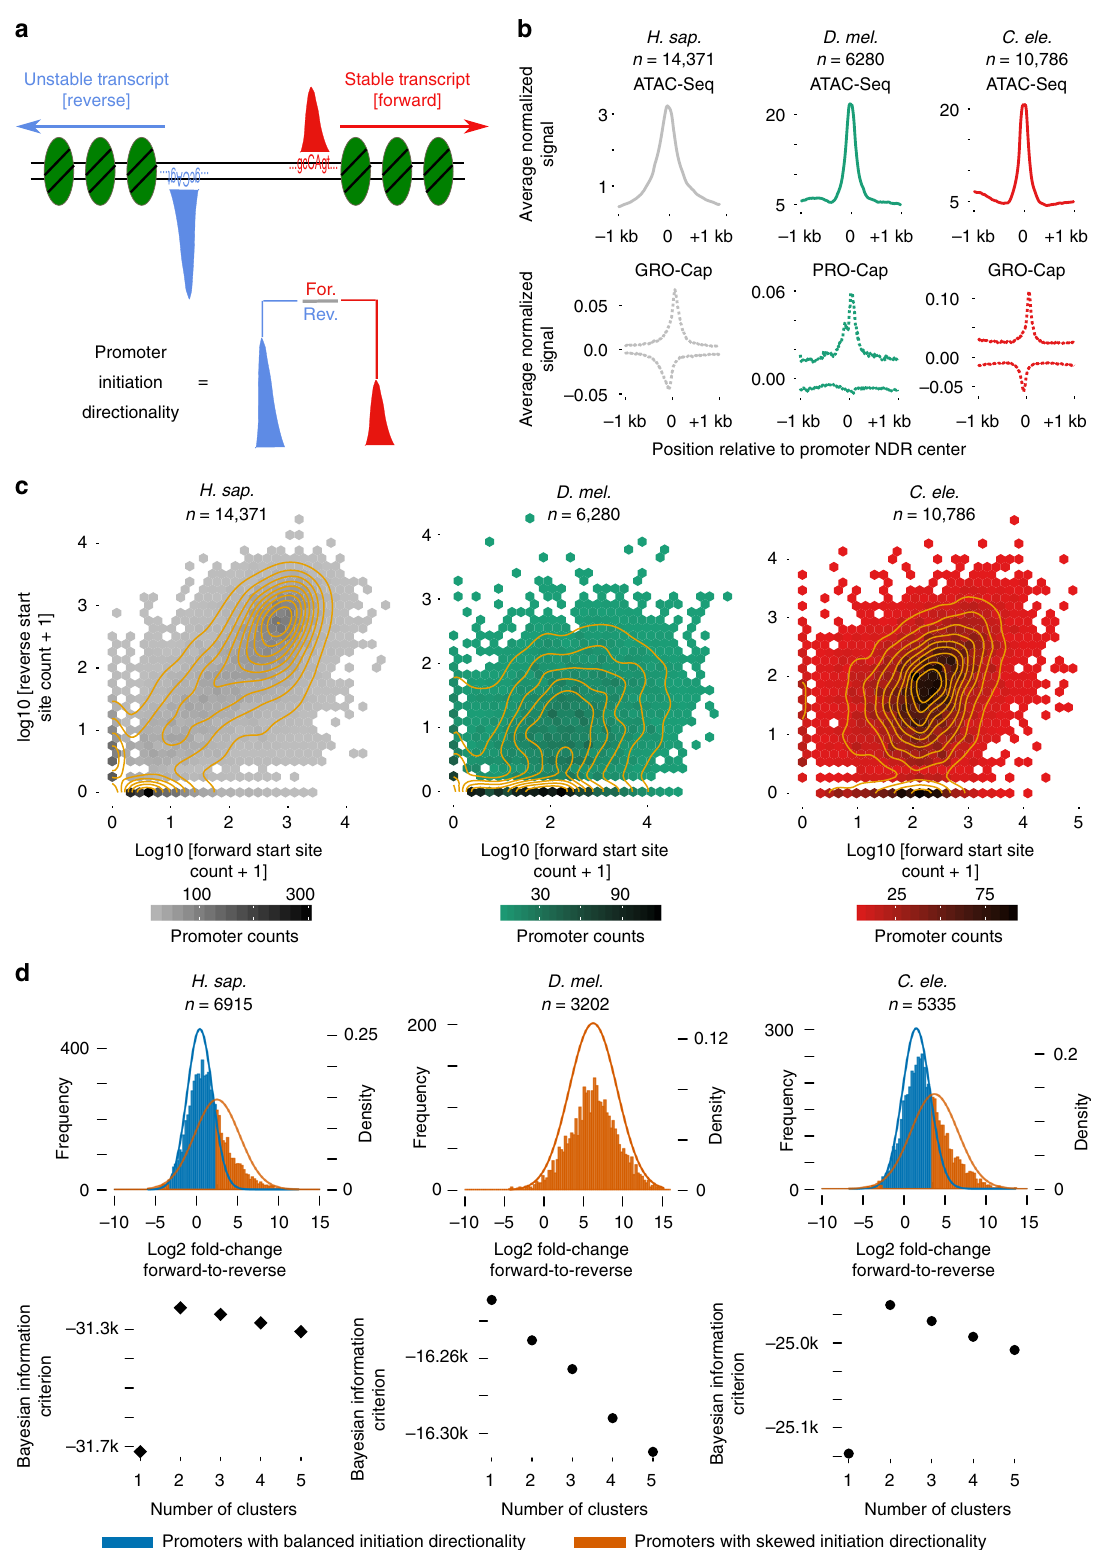
Fig. 1 Variation of promoter initiation directionality. a Schematic of divergent transcription initiation from promoter regions. b Average depth-normalized ATAC-seq (solid line) coverage and zero-to-one-scaled PRO/GRO-cap (dotted line) coverage relative to promoter NDR midpoints as de fi ned by ATAC- seq. c Forward direction (annotated gene) vs. reverse direction PRO/GRO-cap counts displayed as contour and hexbin scatter plots for the same promoter NDRs as b . d Mixture model (top) and Bayesian Information Criterion analysis of cluster numbers (bottom) for forward/reverse PRO/GRO-cap count ratios for promoter NDRs containing signi fi cant forward initiation. A pseudo count of 1 was added to numerators and denominators. Lines represent density of theoretical Gaussian distributions learned from the data, histograms represent observed